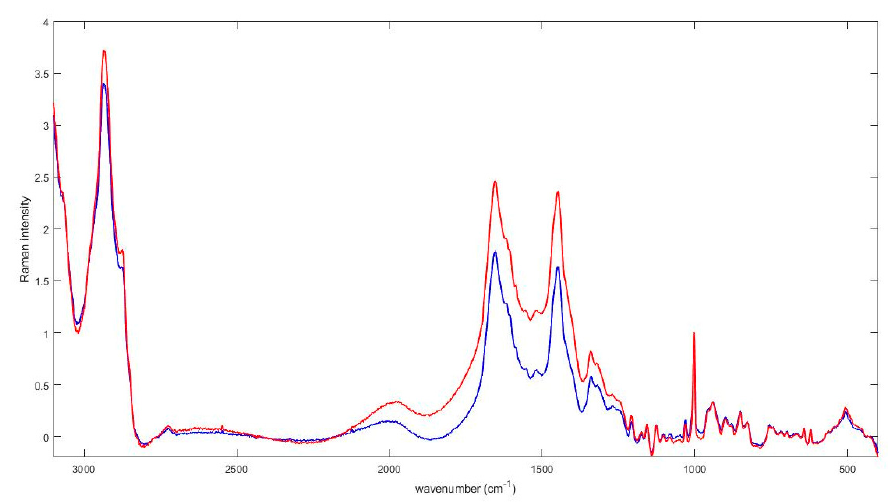
Figure 1. Average serum Raman spectra of non-CD (blue line) and CD (red line) patients. The three areas used for analysis were the 1550–1750 cm − 1 spectral range, the 1400–1500 cm − 1 spectral range, and the reference region of the Phe peak, around 1000 cm − 1 .